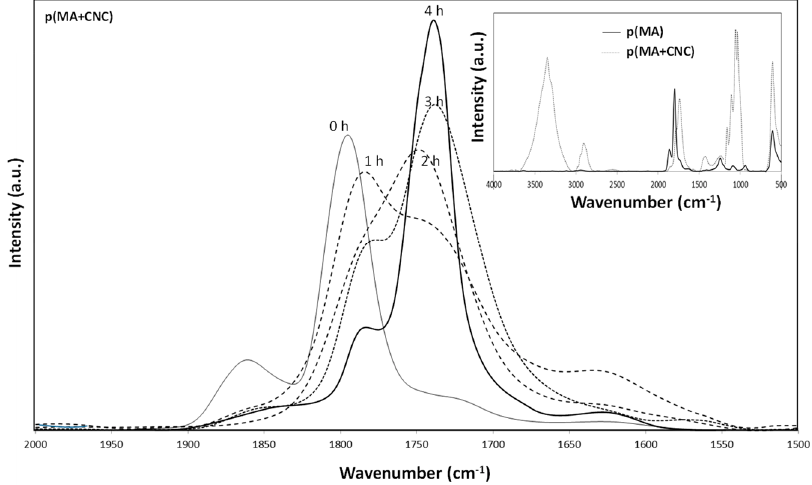
Figure 6. FTIR analysis of p(MA) and p(MA+CNC) films after deposition (inset picture) and effects of progressive hydrolysis of p(MA+CNC) in controlled moist air with times from 0 to 4 h. For p(MA), spectral bands are also present at 1240 cm − 1 (cyclic conjugated anhydride